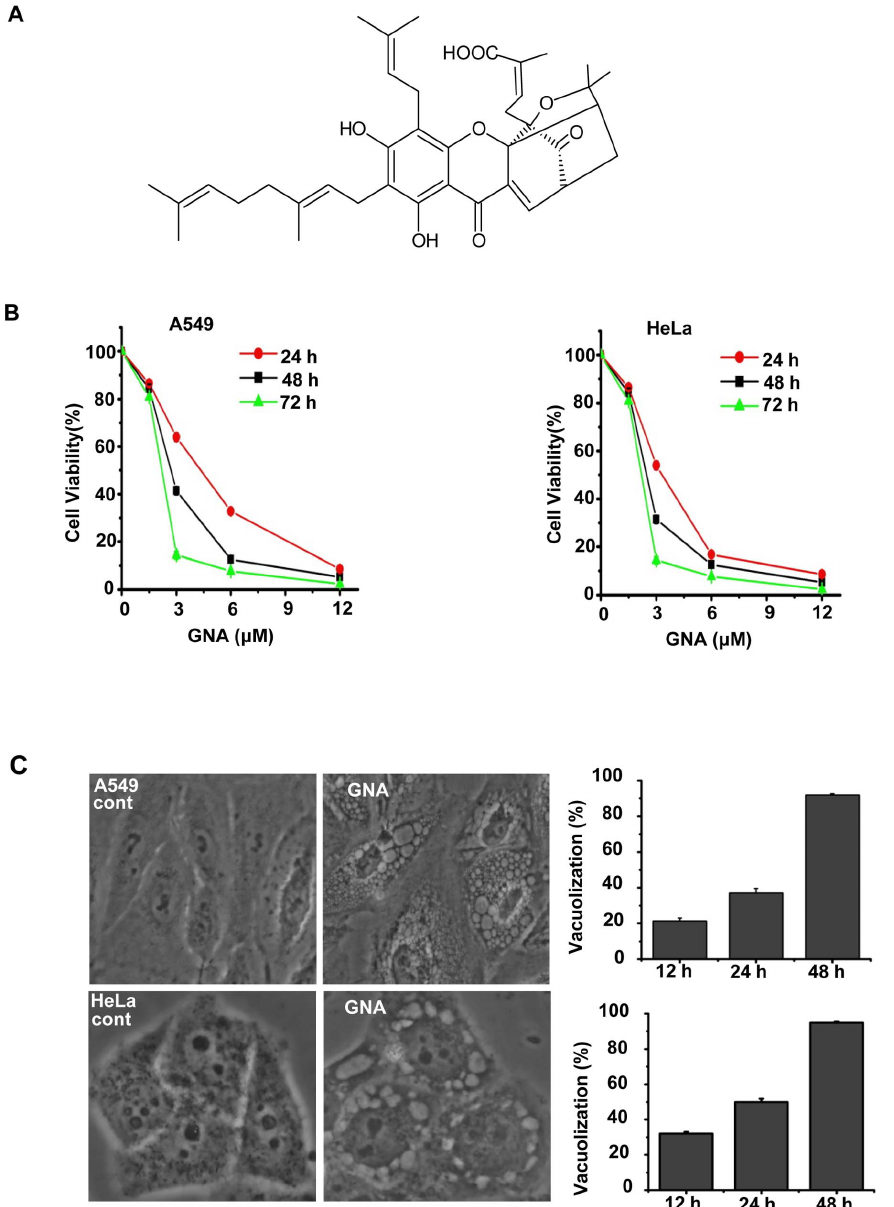
Figure 1. GNA inhibits growth and induces cell death in cancer cells. A, The chemical structure of GNA. B, GNA inhibits growth and inhibits cell death in cancer cells. A549 and HeLa cells were treated with various concentrations of GNA for the indicated periods of time, and cell proliferation was analyzed by the MTT assay. C, Untreated cells (control) or cells treated with 3 m M GNA for 24 hours were directly observed under a phase contrast microscope (left) and cell vacuolization was quantitated (right); at least 600 cells were observed. Means 6 SEM, n=3.